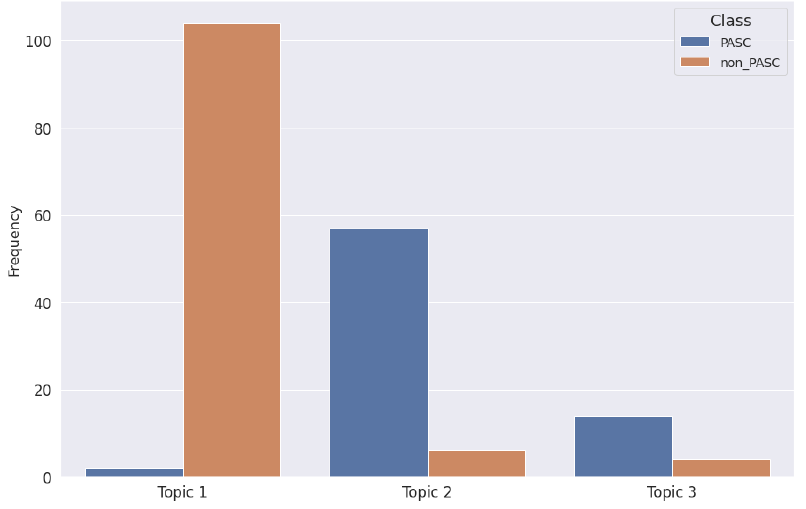
Figure 5. Bar chart describing the distribution of topics modeled trough the LDA approach w.r.t. PASC or non-PASC classes.